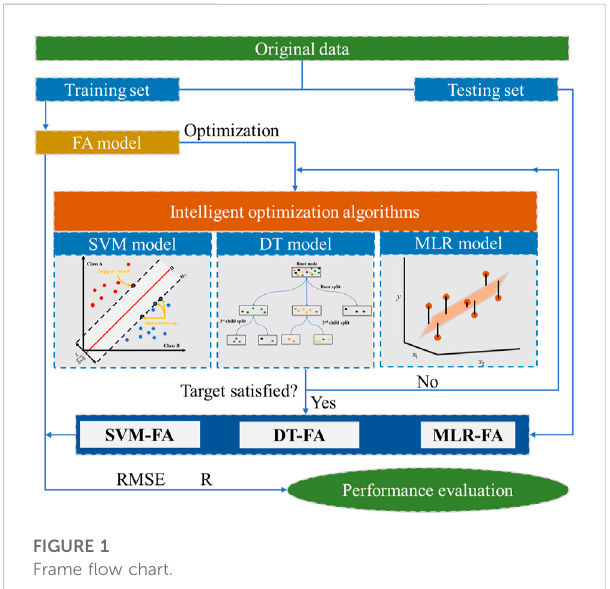
FIGURE 1 Frame fl ow chart.